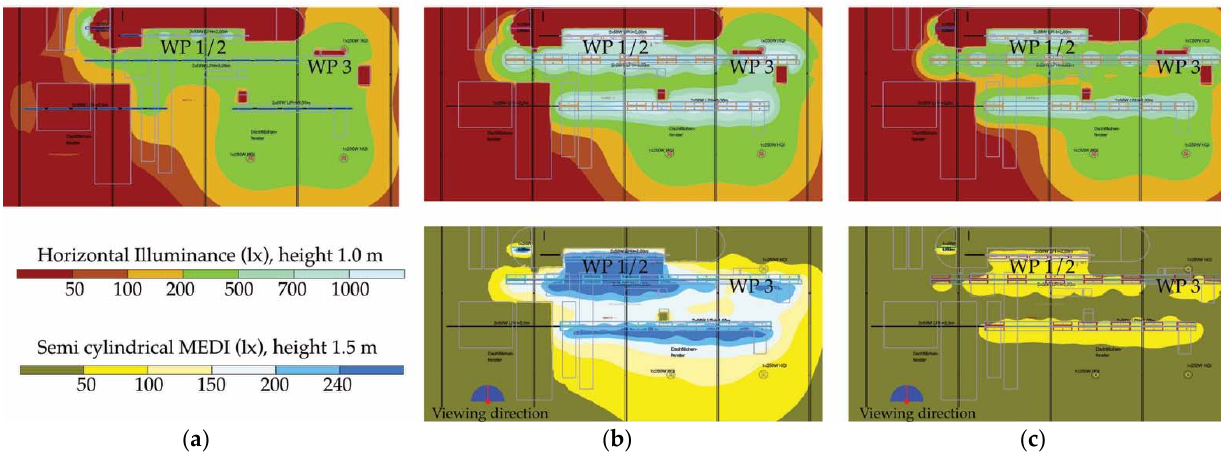
Figure 4. Simulation results for the photopic and melanopic models. The top panels show a visualization of the lighting scenario. The use of color is purely qualitative. Middle panels show the photopic illuminance at task level (lx, 1.0 m height) in a false-color scale floor plan. The bottom panels show the scales and the MEDI (lx, 1.5 m height) in a false-color scale floor plan. ( a ) Stock lighting. An approximate lighting distribution was used for the tub lights. Fluorescent lamp specifications were according to the fitting found on site (mostly 2 × 58 W). ( b ) Morning scenario with a high melanopic setting. ( c ) Night-time scenario with a low melanopic setting.